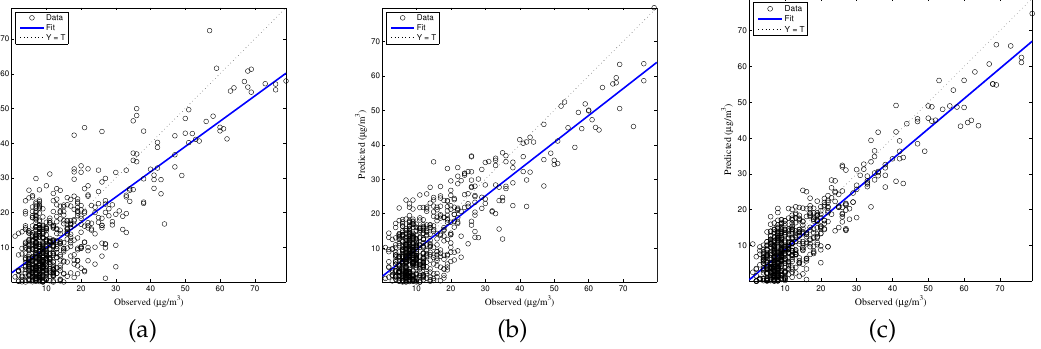
Figure 7. Comparison of prediction results among MLR, FFANN-BP, and ELM. SO 2 predictions ( a ) MLR; ( b ) FFANN-BP; ( c )